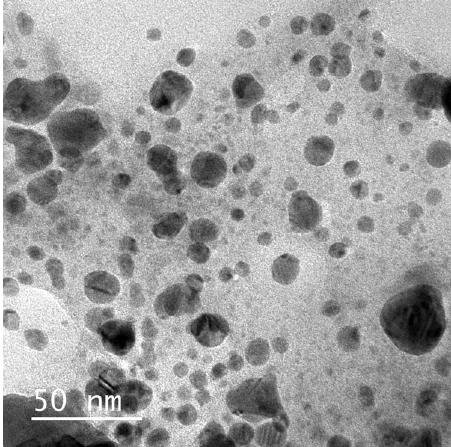
Figure 4: TEM micrographs of phycosynthesized Sp